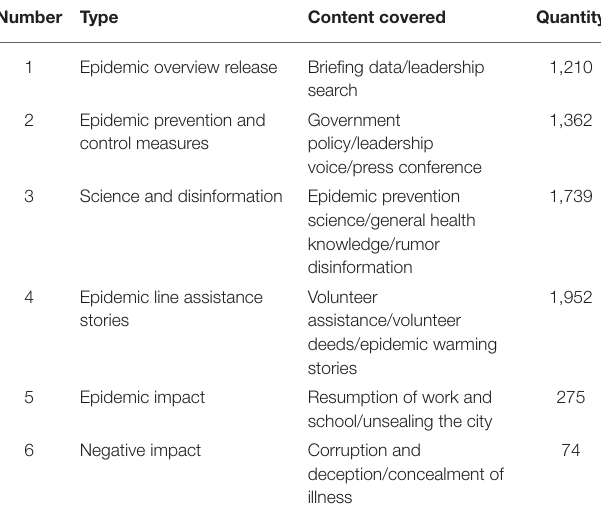
TABLE 2 | Classification of the type of public health emergency tweets, number, and